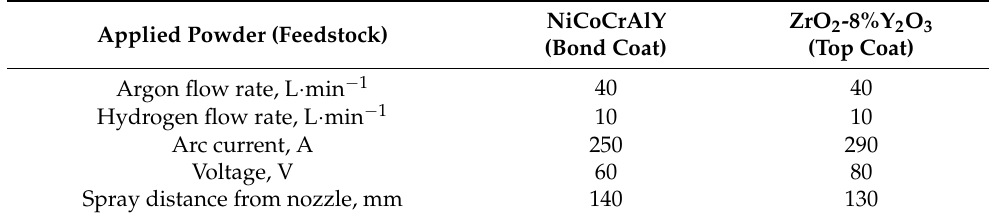
Table 3. Applied plasma spray processes for NiCoCrAlY bond coat and ZrO 2 -8%Y 2 O 3 top coat on 08Kh18N10 stainless steel.